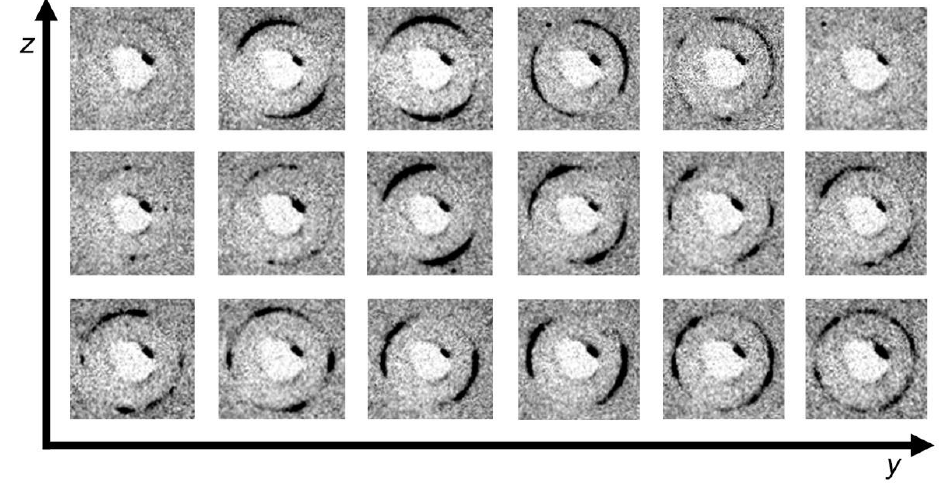
Figure 27. Map of the director field orientation inside the LC volume of an inhomogeneous PDLC film. Horizontal and vertical scans were performed in regular steps of 2 µm.